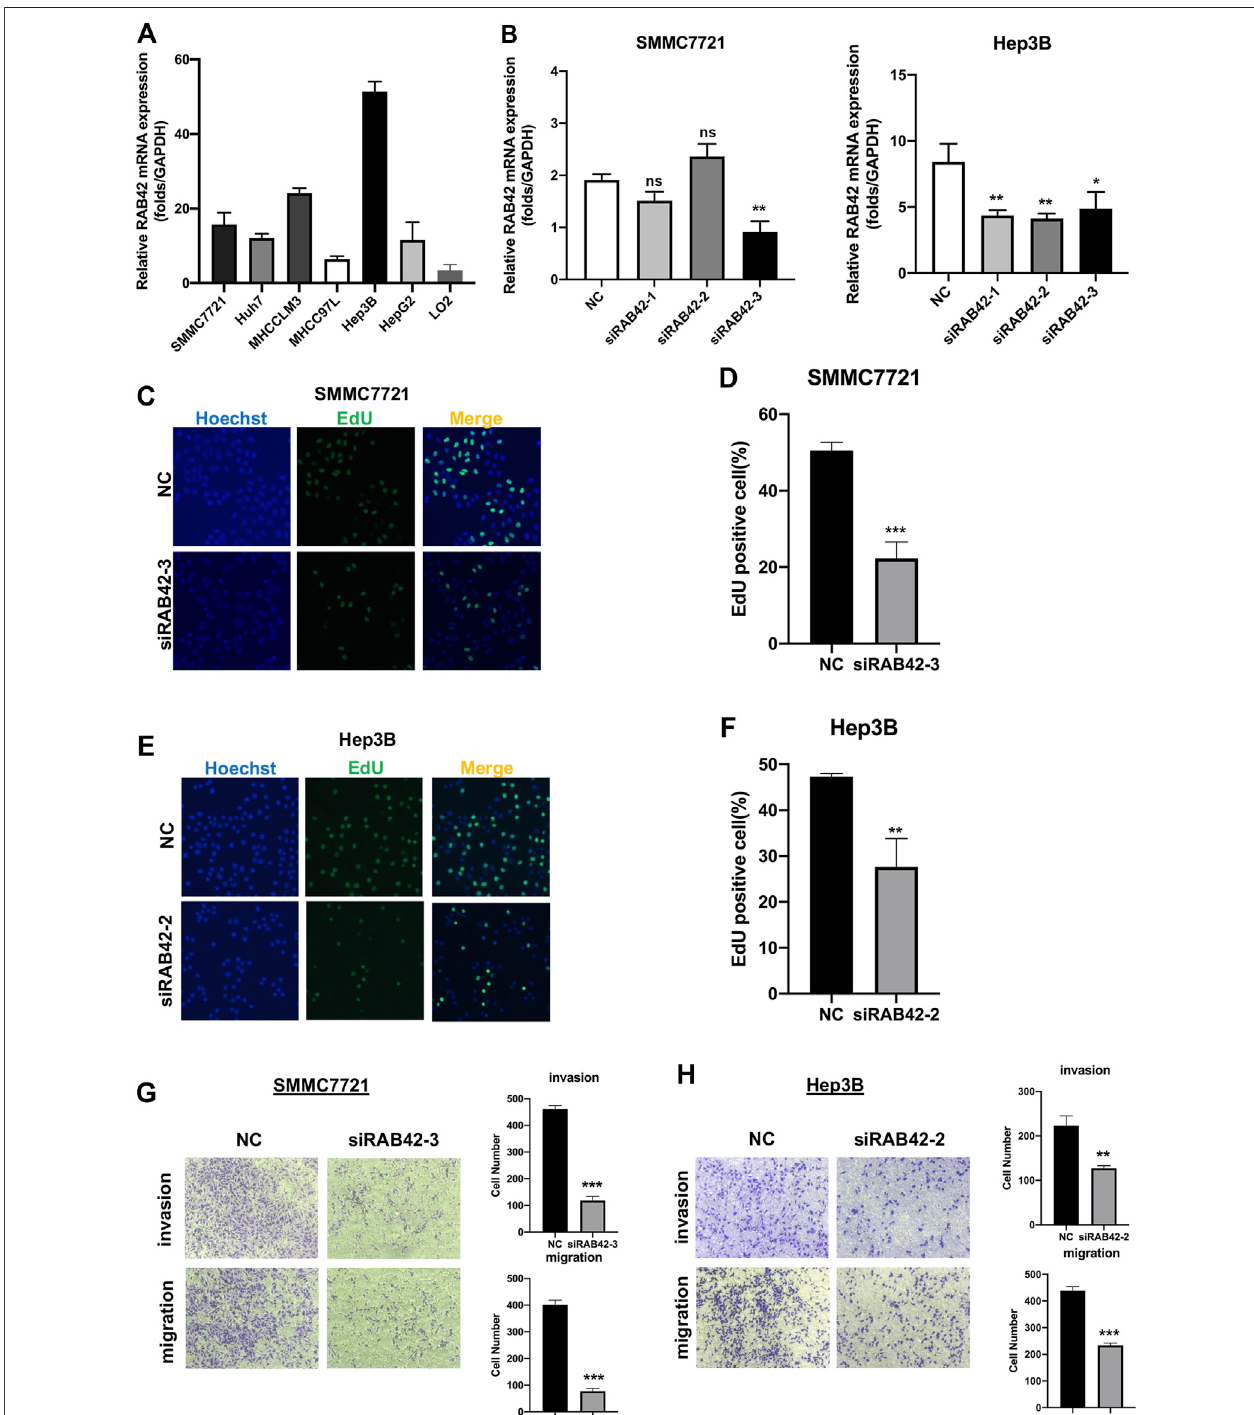
FIGURE 10 | Knockdown of RAB42 inhibited the proliferation, invasion, and migration of liver cancer cells. (A) qRT-PCR assay was performed to compare the mRNA expression level of RAB42 in different liver cancer cell lines, including SMMC7721, Huh7, MHCCLM3, MHCC97L, Hep3B, HepG2 and normal hepatic cell line, LO2. n = 3. (B) qRT-PCR assay was performed to detect the silencing ef fi ciency of RAB42 by three different siRNA in SMMC772 cells and Hep3B cells. Data were presented as the mean ± SD, n = 3, * p < 0.05, ** p < 0.01. ns, no signi fi cance; siRNA, small interfering RNA; NC, negative control. (C,D) Representative images of the EdU assay of SMMC772 cells transfected with siRAB42-3 and quantitative measurement of the proportion of EdU-positive SMMC7721 cells. Silencing RAB42 expressiondecreasedtheproliferationofSMMC7721cells.Datawerepresentedasthemean±SD, n =3.*** p < 0.001. (E,F)